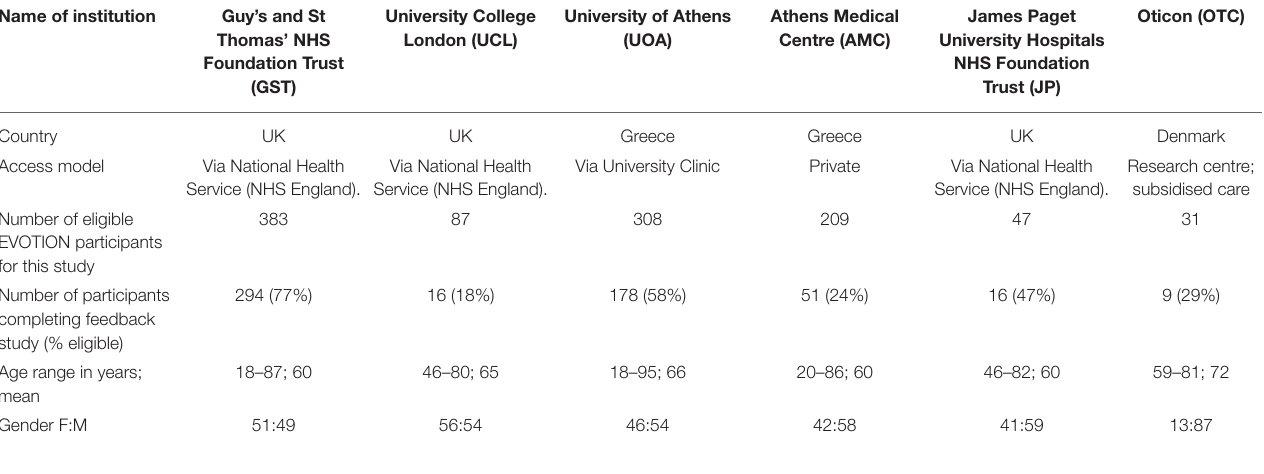
TABLE 1 | Participant recruitment at different institutions. Name of